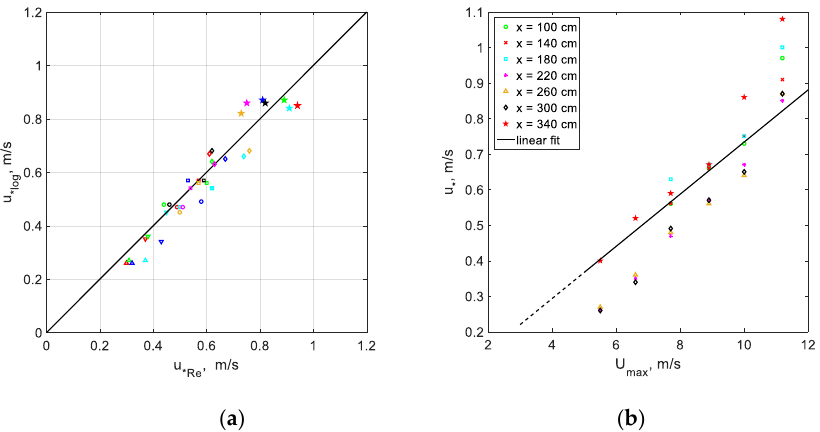
Figure 5. Measurements of the friction velocity u ∗ . ( a ) Comparison of friction velocities obtained by logarithmic fit of profiles as shown in Figure 2 and by the eddy correlation method, as shown in Figure 4; various symbols and colors denote fetches and wind velocities, respectively. ( b ) Dependence of friction velocities measured from the logarithmic velocity profiles on wind velocity U max .